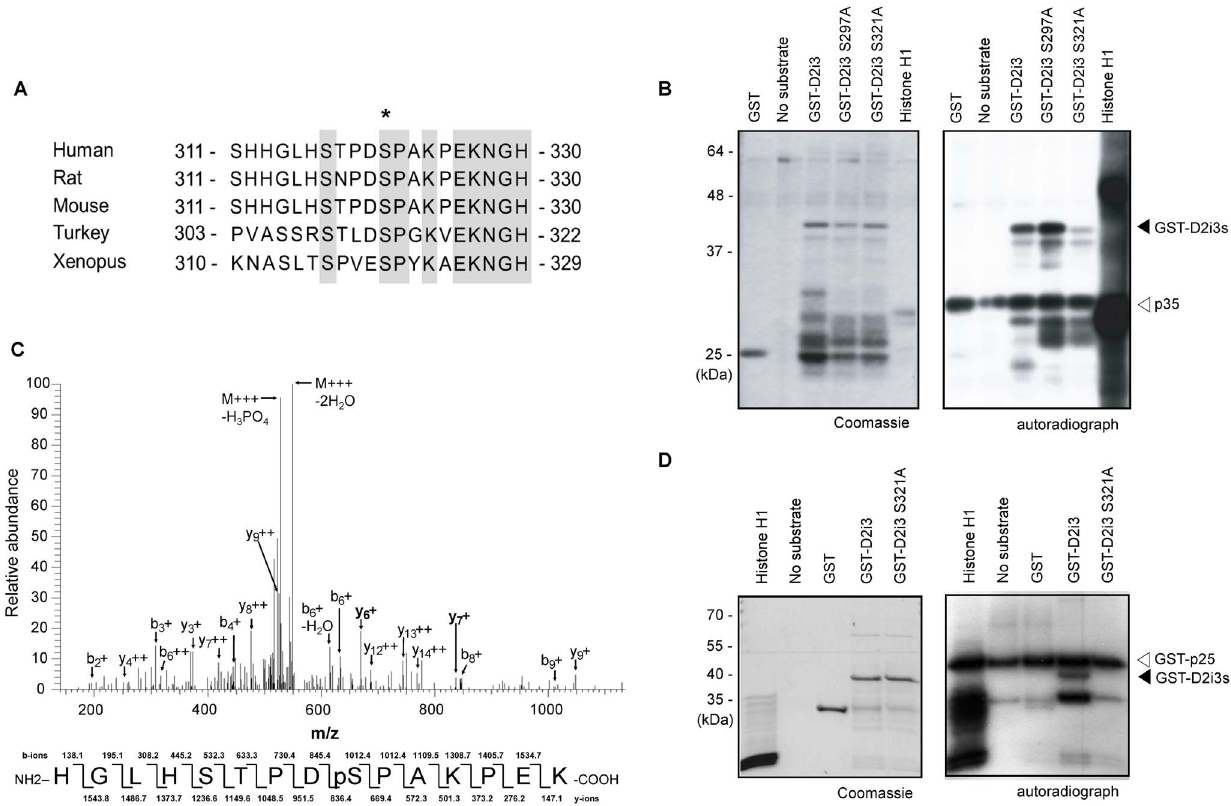
Figure 1. Cdk5 phosphorylates serine 321 in the third intracellular loop of DRD2 invitro. (A) Amino acid sequence alignment showing conserved regions of the DRD2 from various species (shaded). The potential Cdk5 phosphorylation site is indicated by an asterisk. (B) IP-linked in vitro kinase assay with recombinant GST-D2i3 and GST-D2i3 mutant proteins. Cdk5/p35 complex enriched from mouse brain extract by anti-p35 immunoprecipitation was used for kinase reactions. An autoradiograph of phosphorylated proteins is shown along with Coomassie brilliant blue staining of the same gel. Arrowhead indicates radioactive signal corresponding to GST-D2i3s and open arrowhead indicates radioactive signals from p35. (C) MS/MS spectrum of the phosphorylated peptide fragment of D2i3. The theoretical fragmentation patterns are shown below the spectrum. Among all the fragment ions, the detected y- and b-ions are denoted in the spectrum. The y 6 and y 7 ions strongly indicate the phosphorylation of serine 321. (D) In vitro kinase assay with purified Cdk5/GST-p25 complex using GST-D2i3 and GST-D2i3 mutant proteins. Phosphorylated proteins were shown in an autoradiograph, along with Coomassie brilliant blue staining. Arrowhead indicates radioactive signal corresponding GST-D2i3 and open arrowhead indicates radioactive signals from